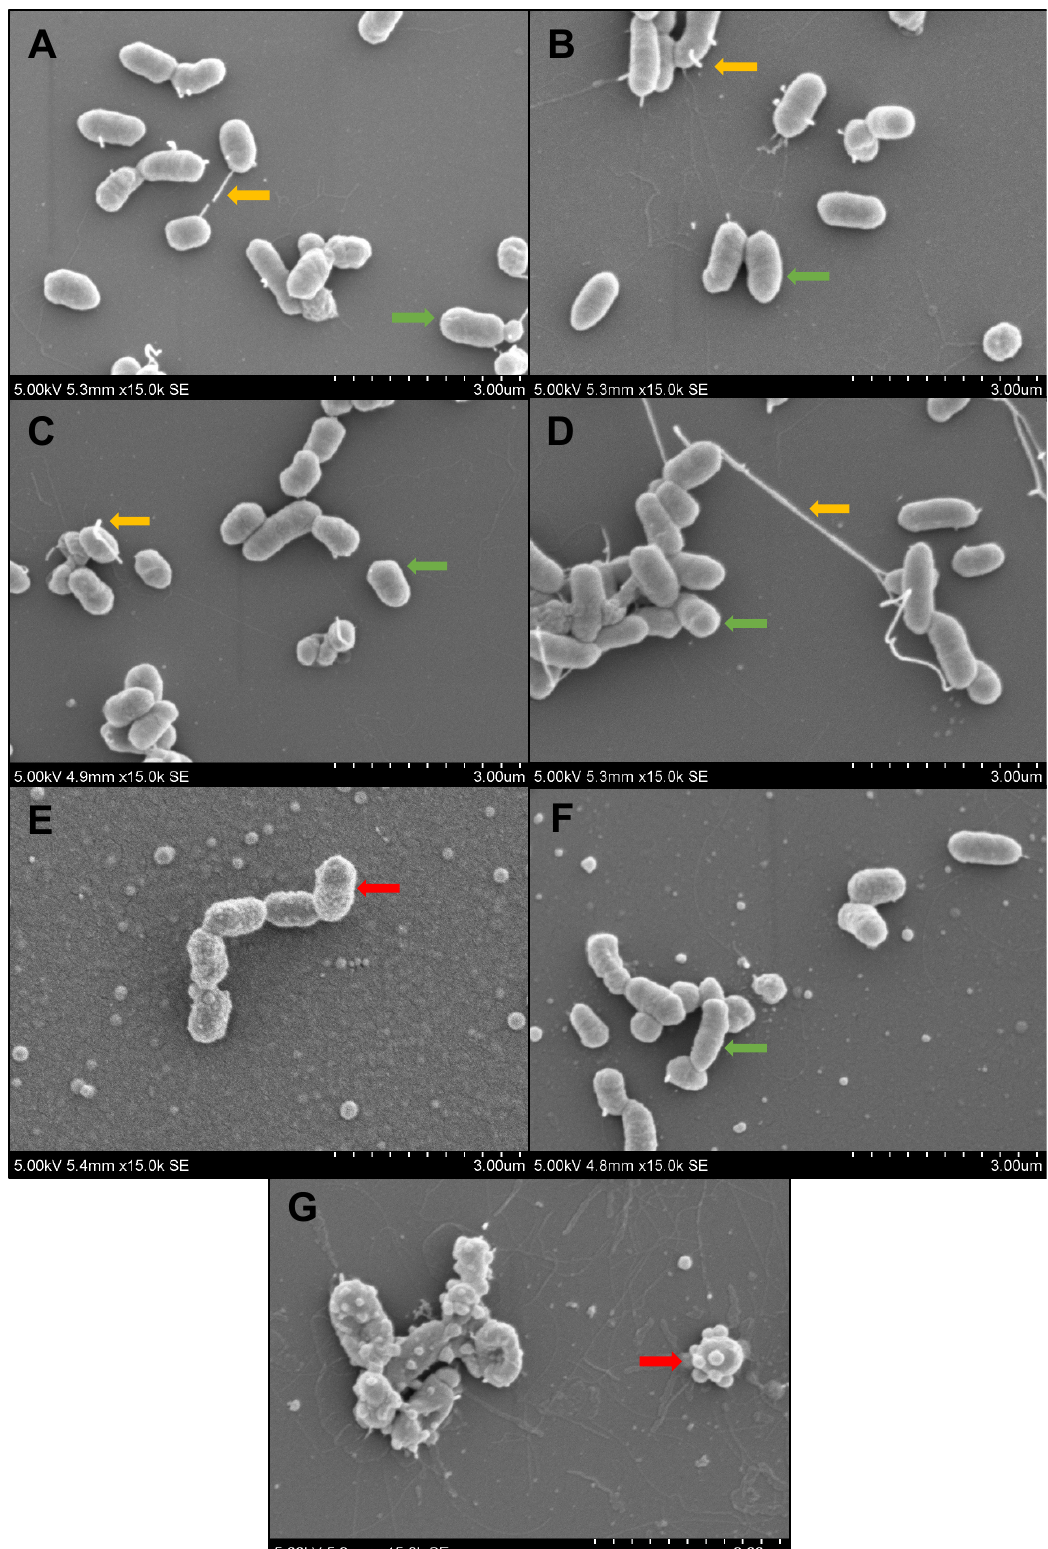
Figure 4. Scanning electron microscopy of E. coli K12 membrane morphology on ( A ) untreated glass, ( B ) NaHCO 3 buffer, ( C ) polydopamine, ( D ) ciprofloxacin, ( E ) Melimine, ( F ) Mel4 and ( G ) RK758. Yellow arrows show normal cellular projections. Green arrows show smooth membrane morphology. Red arrows show abnormal membrane morphology.